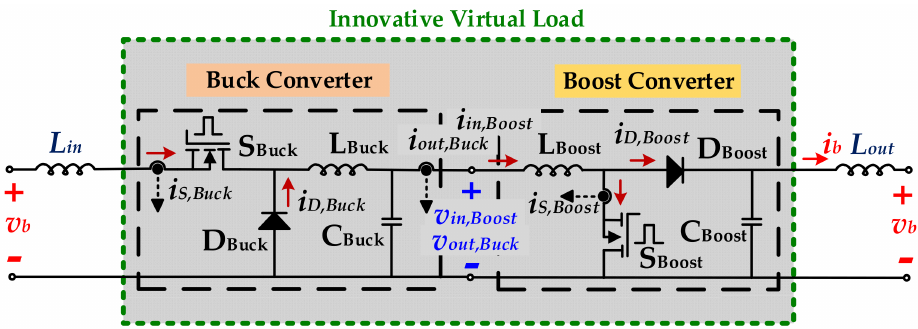
Figure 3. Innovative virtual load topology, incorporating one Step-Down (Buck) and one Step-Up (Boost) converter topology; symbols are in accordance with Table A1 Appendix